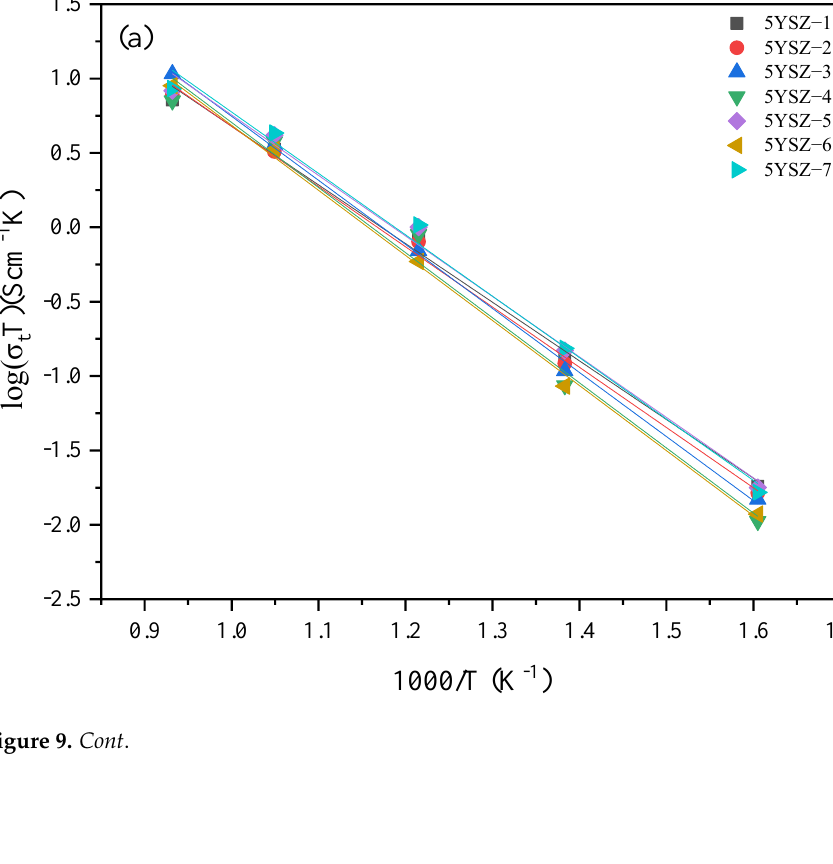
Z ' ( Ω ) Figure 8. Nyquist diagram under different temperatures with 8YSZ-1450 °C. The ionic conductivity of zirconia is mainly determined by the crystal morphology of the zirconia solid solution. Compared with the tetragonal phase, the cubic phase has a higher concentration of oxygen vacancies. The cubic phase content of 5YSZ ceramics in- creased by TSS process, but the cubic phase content of 8YSZ ceramics changed little. With a decrease in the average grain size, the thickness between grains decreases, the grain area increases, and the total effective conductive area increases, making the oxygen va- cancy migration easier.